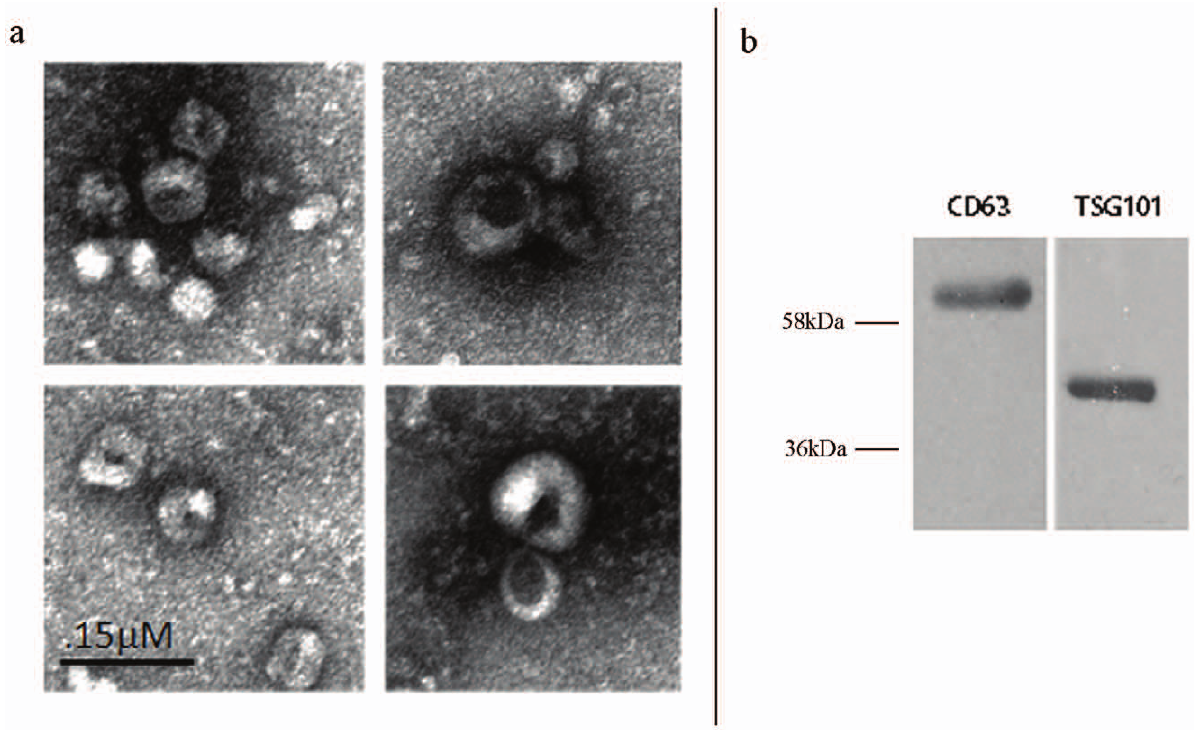
Figure 1. Confirmation that the ultracentrifugation pellet contains exosomes. a Electron microscopy of the ultracentrifugation pellet from serum shows the characteristic spherical shape and size (50–100 nm) of exosomes b. Western blot shows strong staining of the ultracentrifugation pellet with the exosomal membrane markers anti cd63 and TSG101.